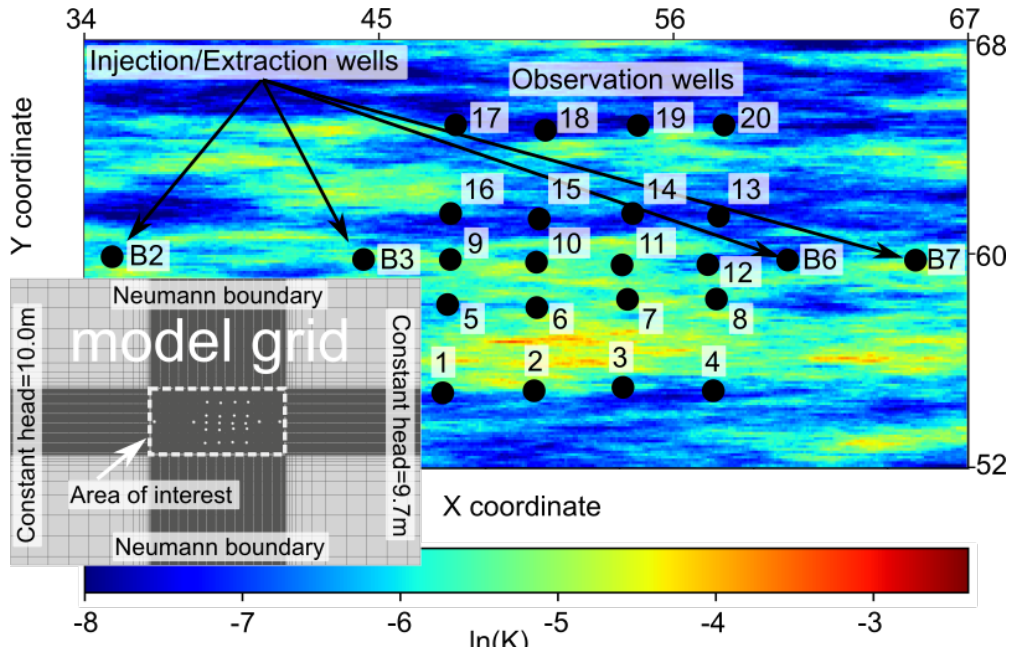
Figure 2. Two-dimensional synthetic log-hydraulic conductivity field (ln(K)) generated for the area of interest, with the injection and extraction wells and observation points (black dots). Inset shows details of the model grid generated for the HydroGeoSphere model, with a refinement within the area of interest (rectangle with a white dotted